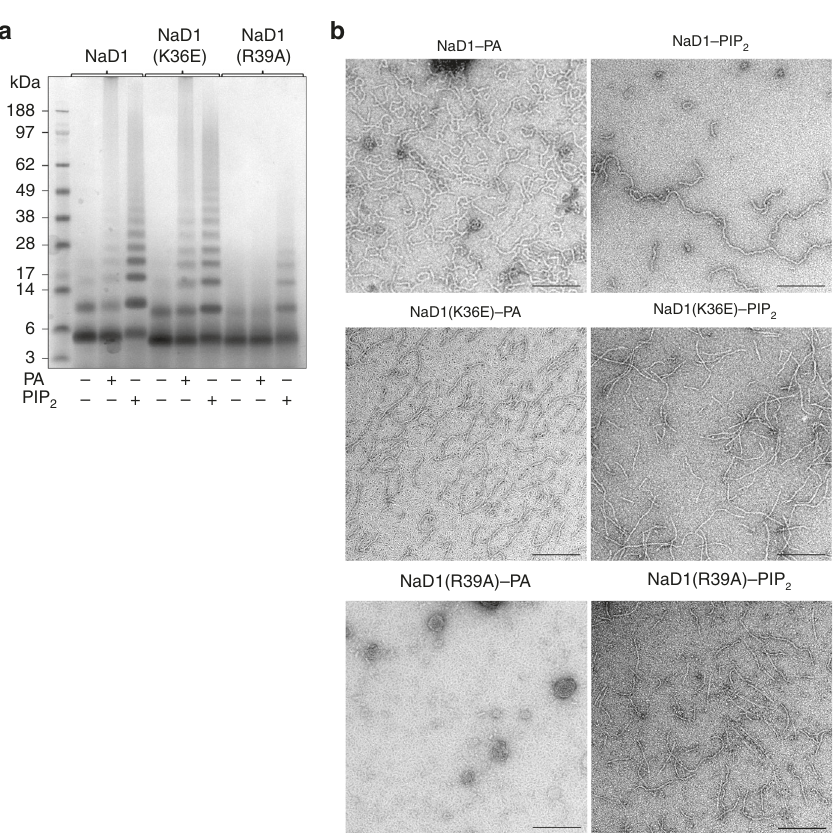
Fig. 6 Site-directed mutagenesis of NaD1. a The ability of NaD1, NaD1(K36E), and NaD1(R39A) to form multimeric complexes in the presence of PA or PIP 2 as determined by protein – protein crosslinking with BS 3 and visualized by SDS-PAGE. b Transmission electron micrographs of NaD1, NaD1(K36E), and NaD1 (R39A) in the presence of PA or PIP 2 . While PIP 2 binding to all three proteins resulted in fi bril formation, PA-mediated fi bril formation is abolished for NaD1 (R39A). Scale bars represent 200